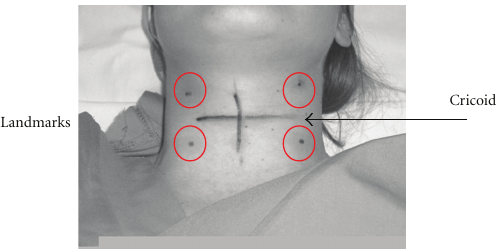
Figure 1: Landmarks used for measurements (in circle) and cricoid cartilage